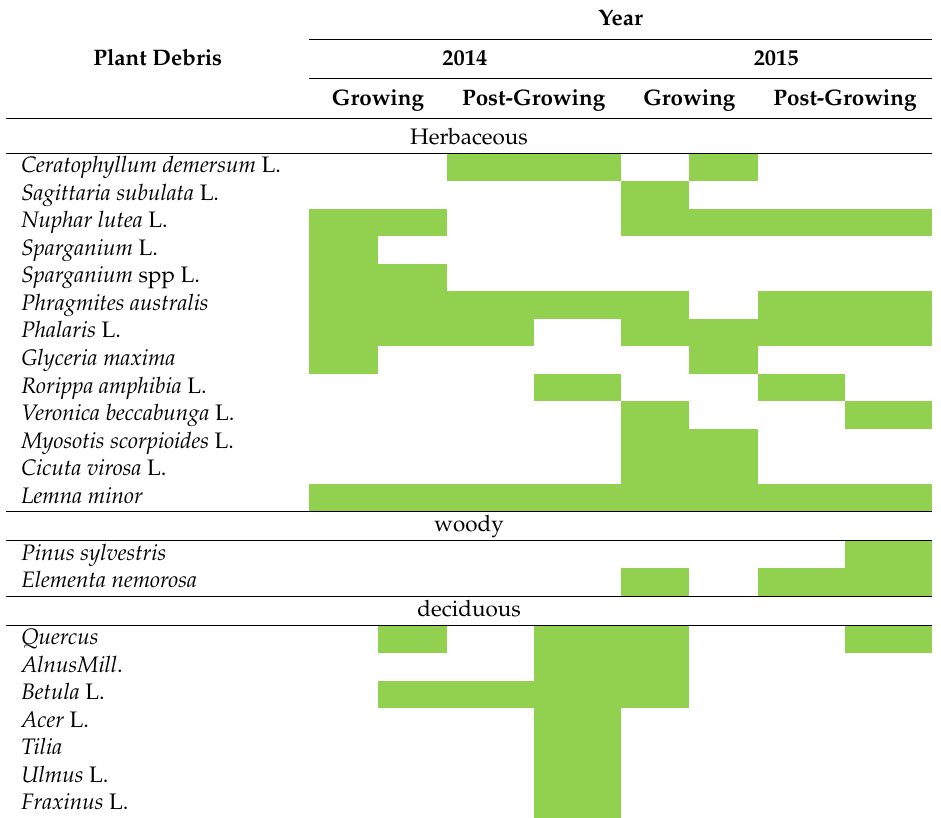
Table 4. Identified species of plant debris and their measurement dates, collected from SHP trash racks on the Wełna River.